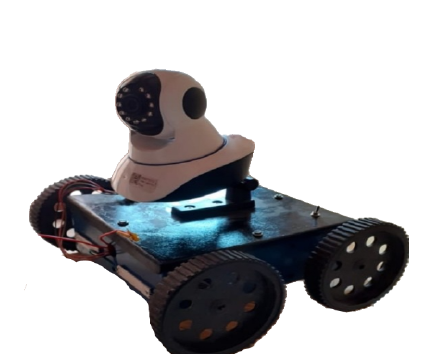
Fig. 3. Working model of UV Sanitization Robot